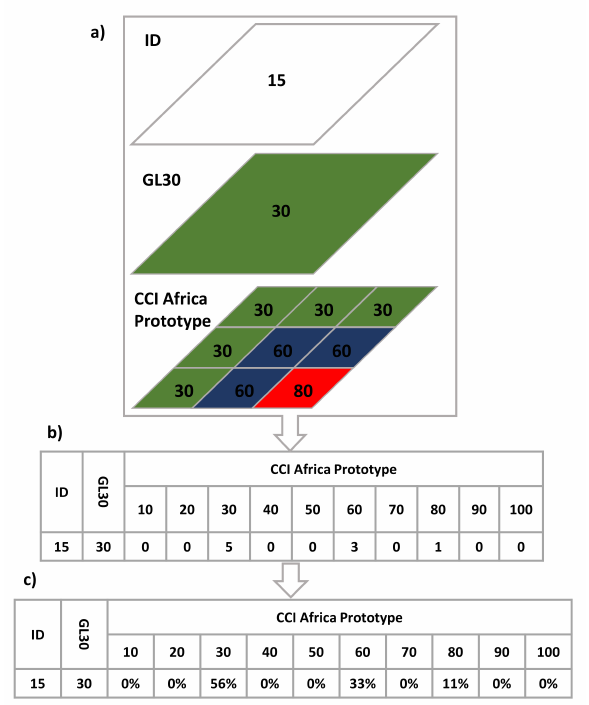
Figure 1. Schematic of the data overlay procedure to compute sub-pixel disagreement on a sample target map pixel i=15 Global Moran I weights were distance based k-nearest neigh- bor weights, where k=8.